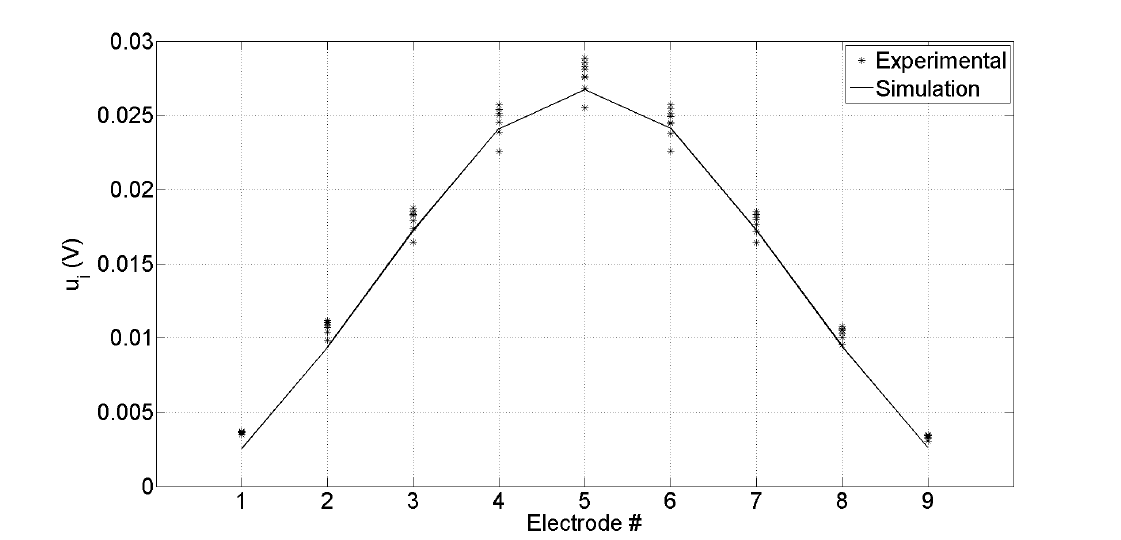
Figure 5. Differential voltage at i th electrode u i = V i − V 0 ; line represents the numerical simulation, markers represent experimental results on 10 different measurements without defects in the sensor.